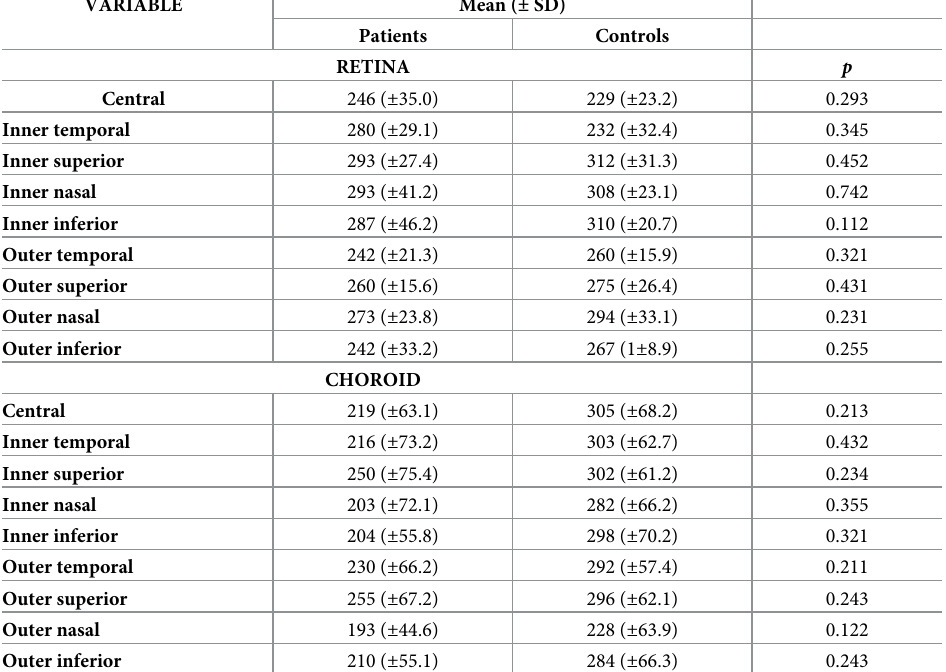
Table 4. Retinal and choroidal thickness ( μ m) by SS-OCT.